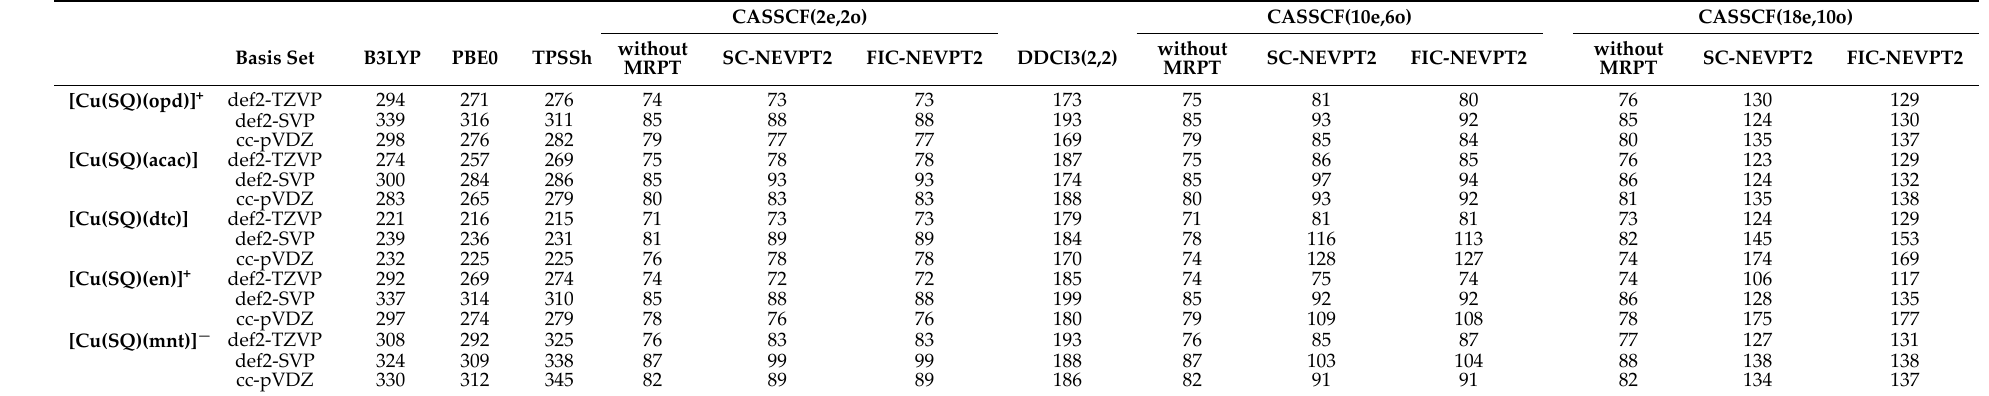
− 1 ) calculated with DFT and ab initio methods for model semiquinonato Cu(II)